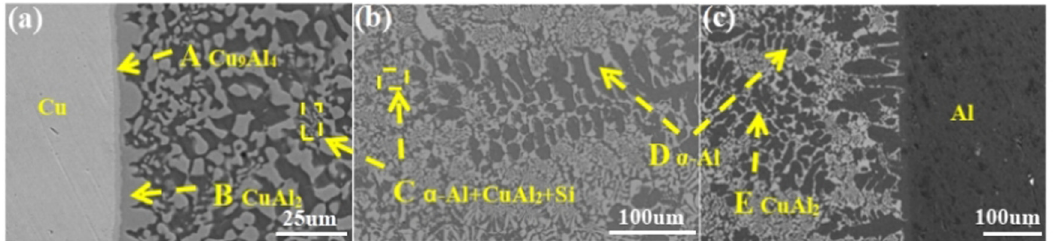
Figure 2: Scanning electron microscope image of the brazing joint of BAl88Si fi ller metal: ( a ) microstructure of the brazing joint interface on the copper side, ( b ) microstructure of brazing seam, and ( c ) microstructure of the brazed joint interface on the aluminum